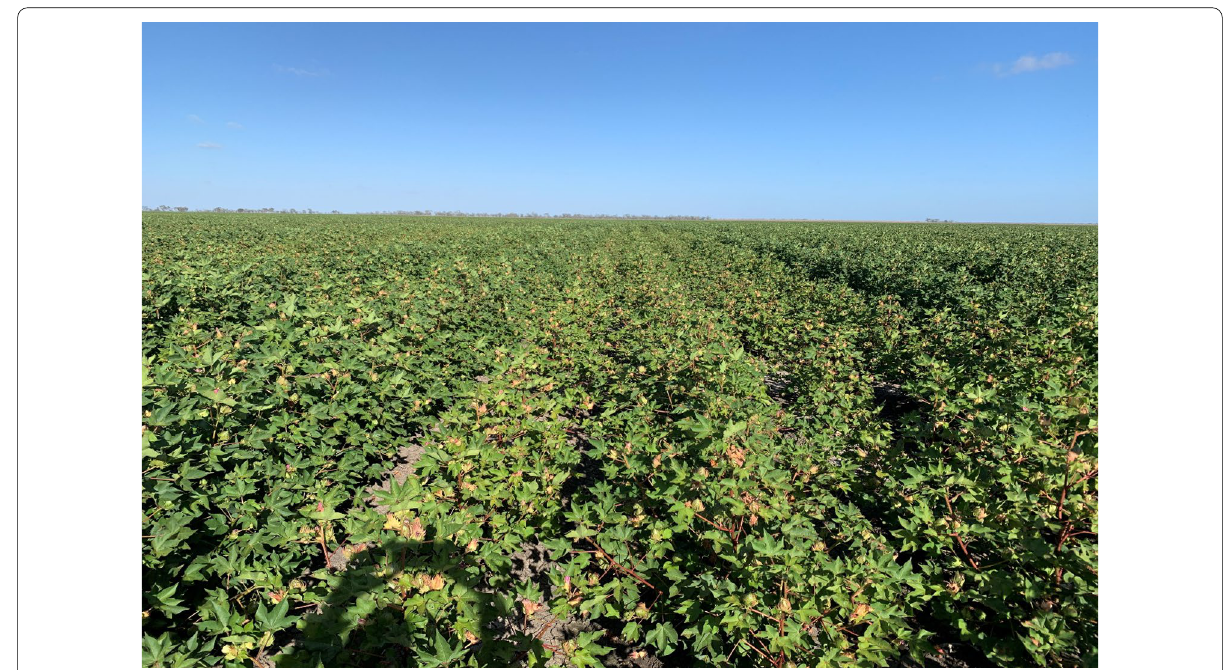
Fig. 1 Image of N deficient cotton plants (Courtesy Baird, Jonathan